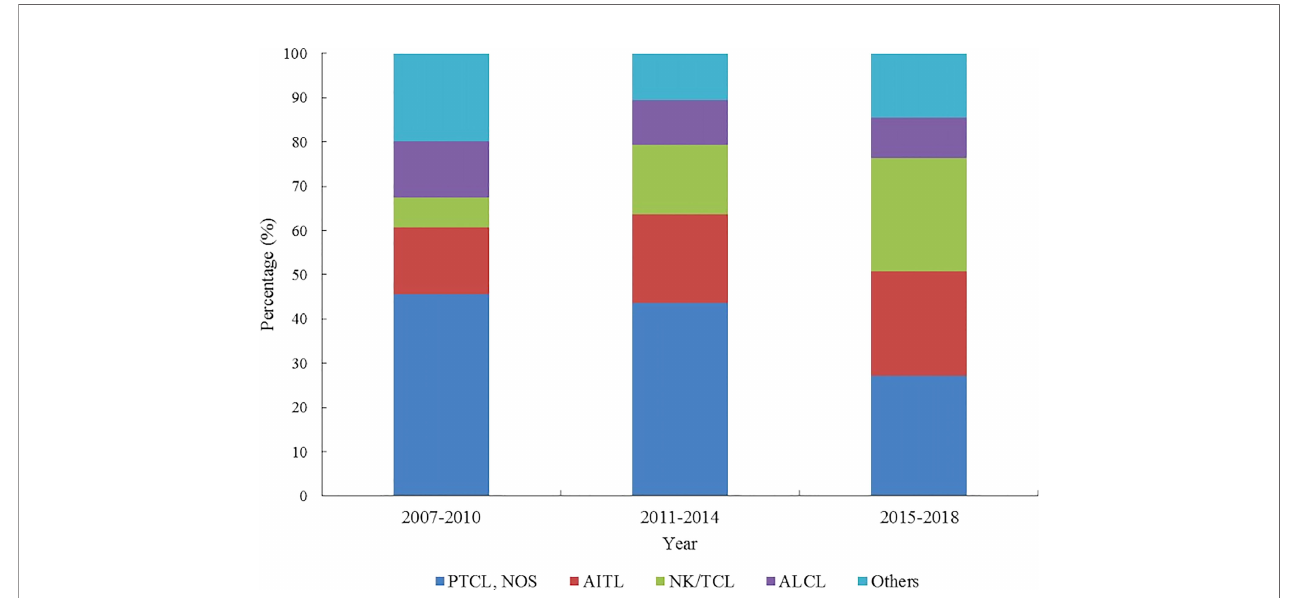
FIGURE 5 | Histology type proportion changes of patients with peripheral T-cell lymphoma in Beijing from 2007 to